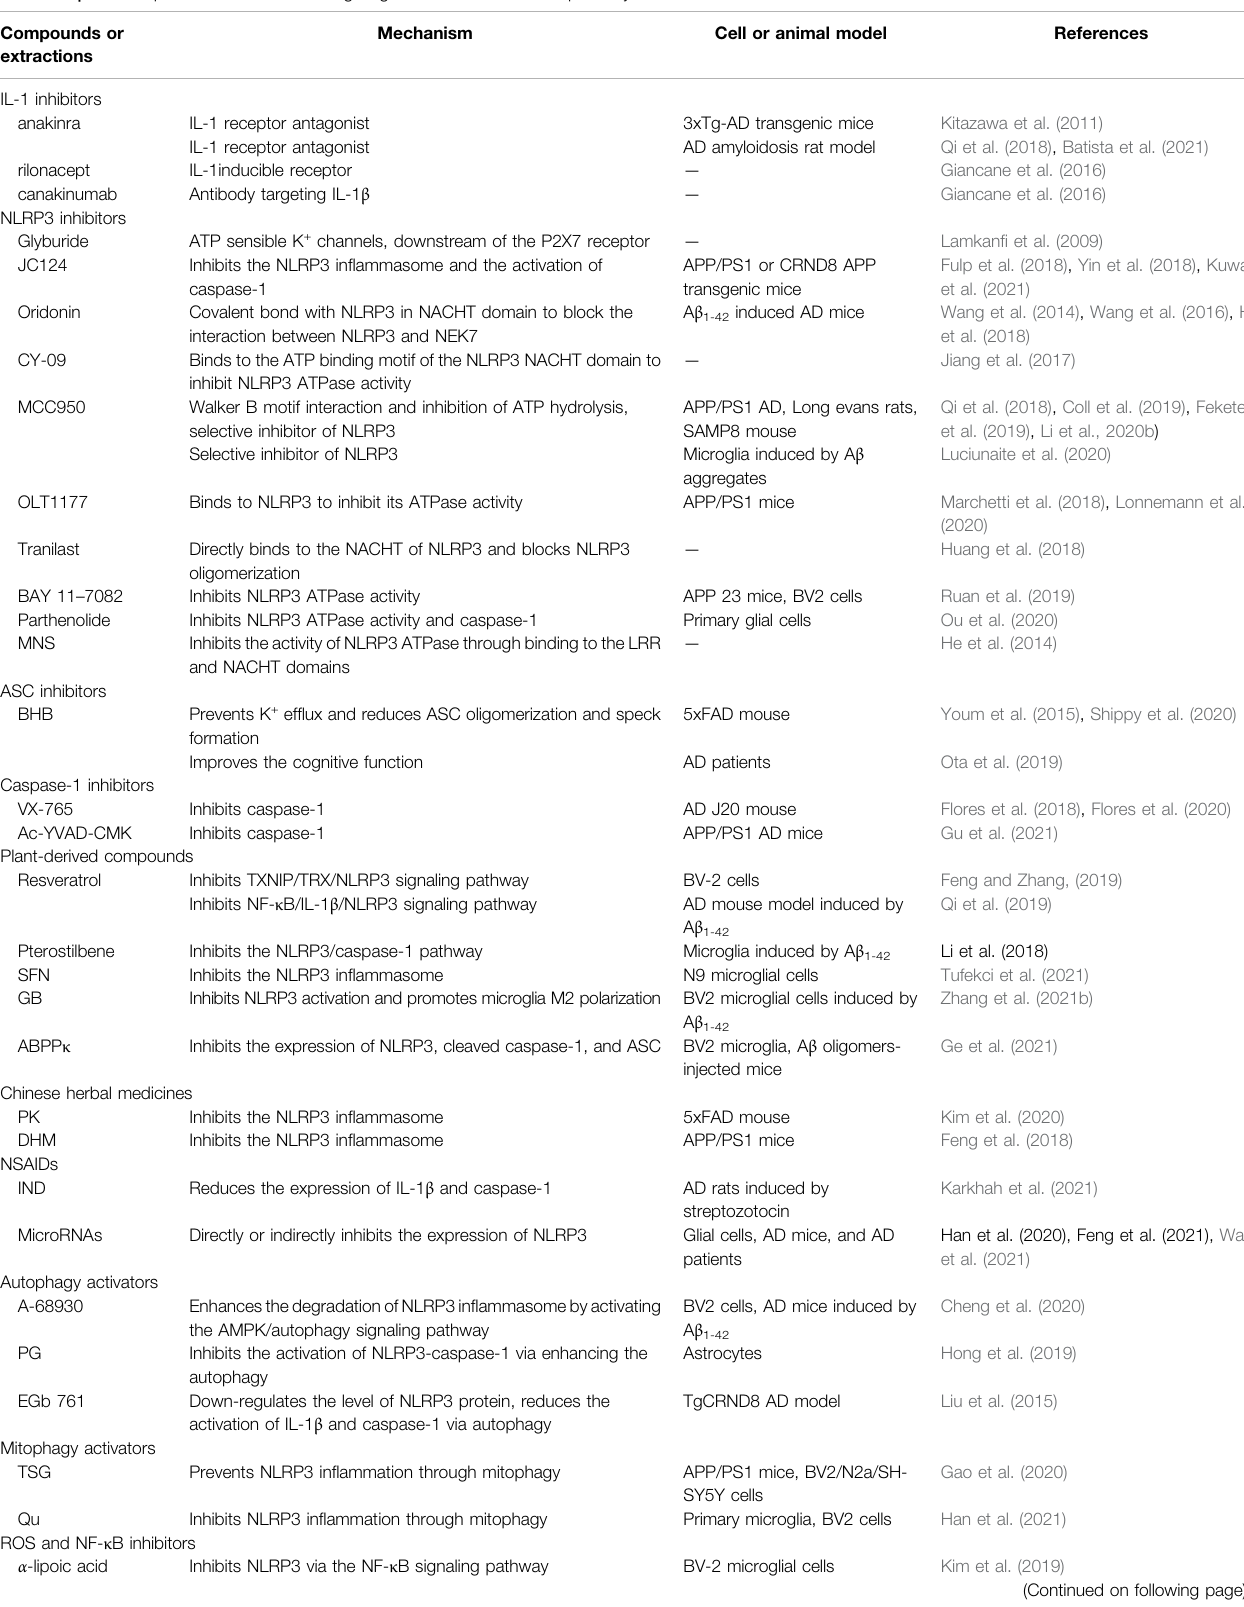
TABLE 1 | The compounds or extractions targeting NLRP3 in fl ammasome pathways in AD. Compounds or